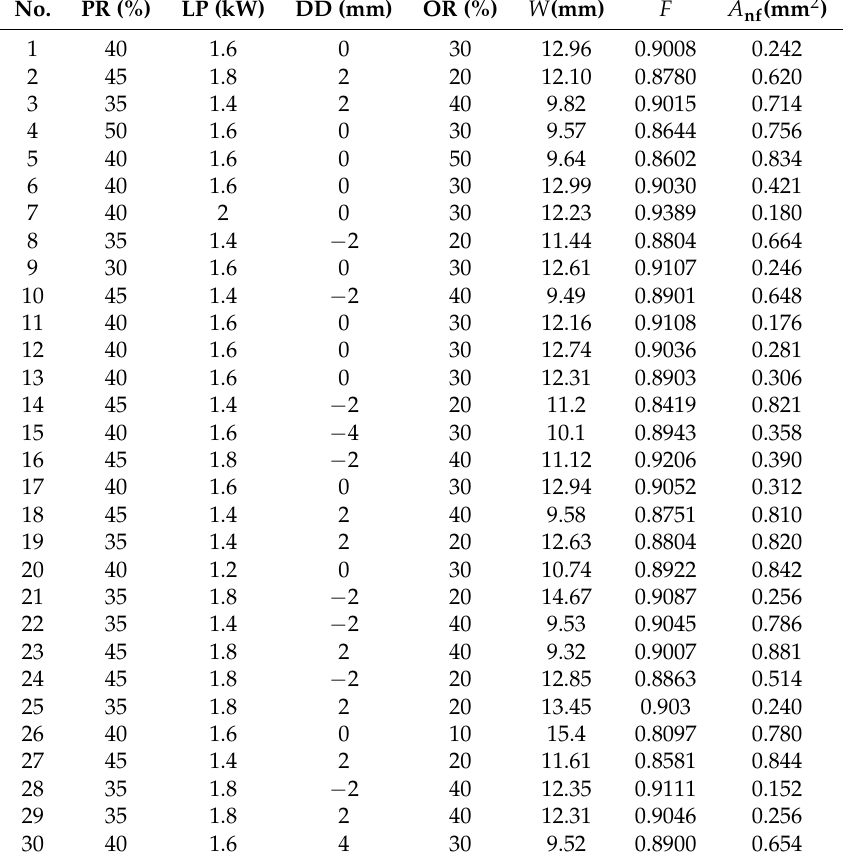
Table 5. Central composite design and